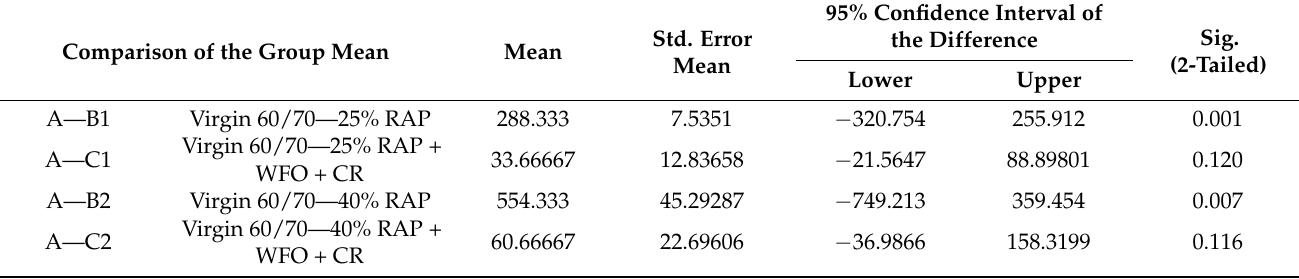
Table 14. The significant difference in the group means for the ITS for the virgin asphalt with RAP and the recycled asphalt mixture.